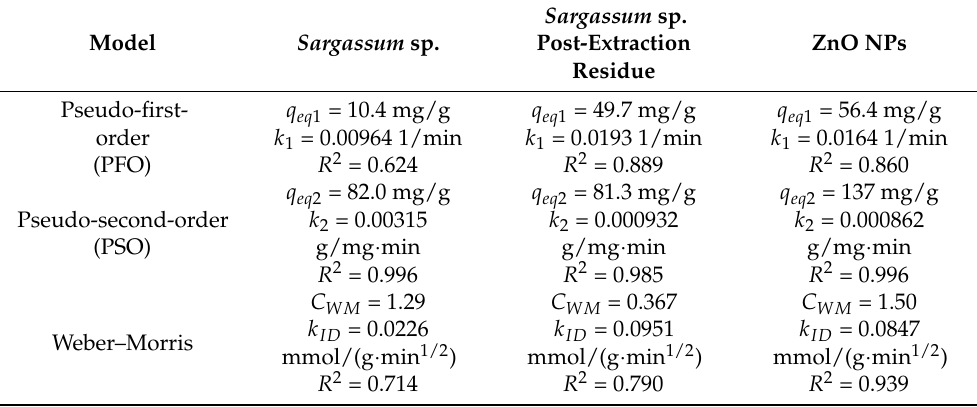
Sargassum sp. Post-Extraction ZnO NPs Residue